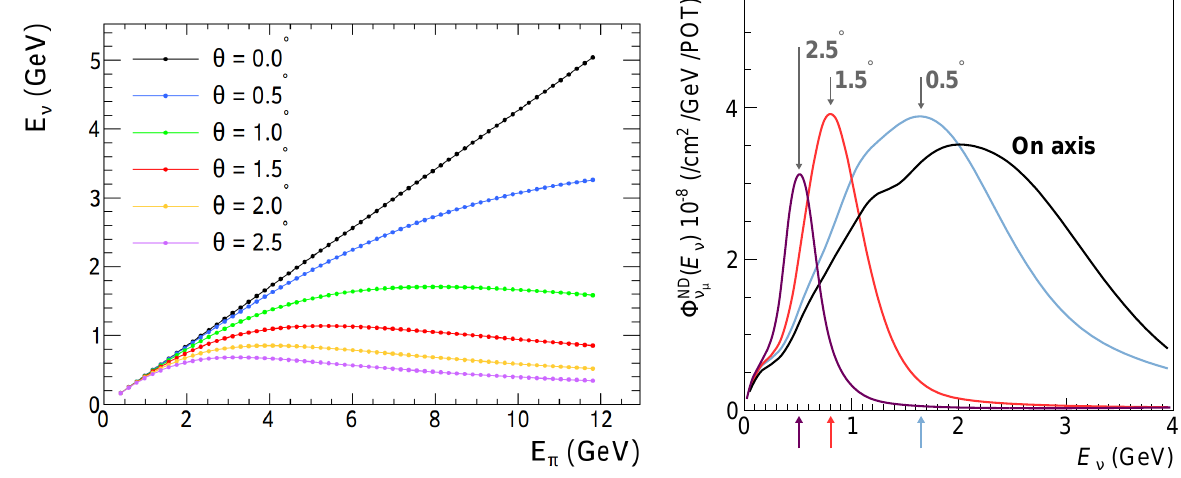
Figure 90. ( Left ): the observed neutrino energy in the lab frame from a decay-in-flight pion as a function of pion energy and observation angle away from the pion momentum direction. ( Right ): the predicted DUNE beam muon neutrino flux at the ND site as a function of off-axis angle. The arrows indicate the peak neutrino energy for three different off-axis